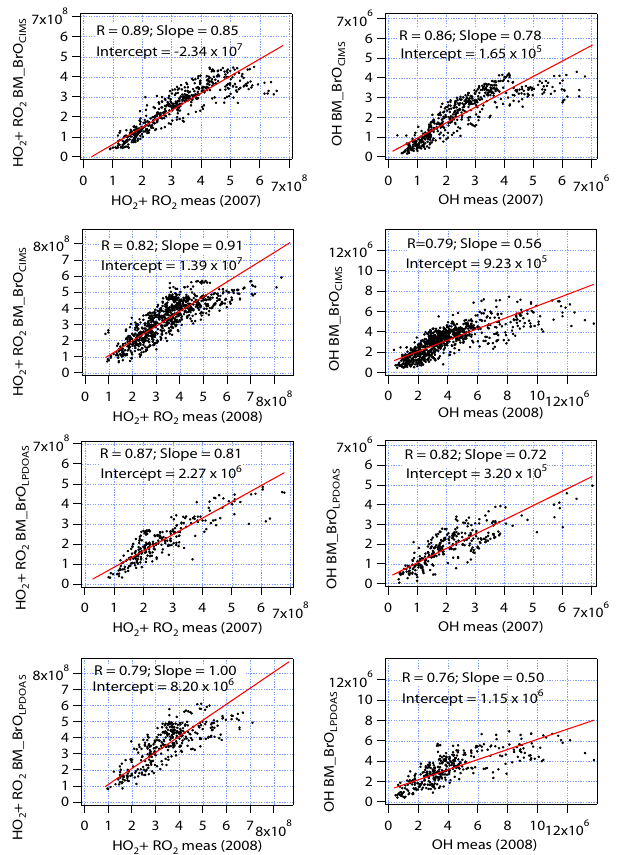
Fig. 6. HO 2 +RO 2 and OH predictions from the base model in- corporating bromine chemistry constrained by BrO measurements by CIMS (BM BrO CIMS ) and LPDOAS (BM BrO LPDOAS ) plot- ted versus the observations in 2007 and 2008. The data are aver- aged on a 10 min time base. The correlation coefficient (R) and the slope and intercept from an equally weighted bivariate regression (red line) for each panel are also denoted in the figure. The units of OH and HO 2 +RO 2 concentrations are moleccm − 3